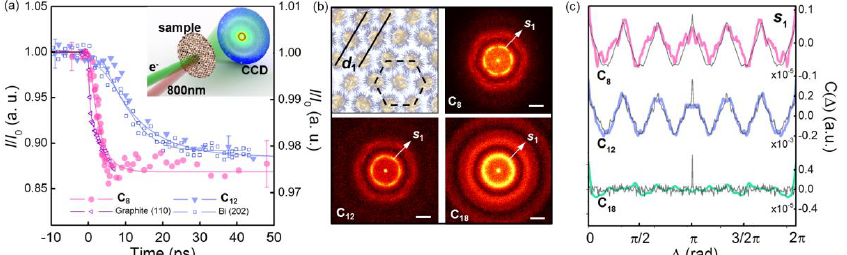
Fig. 1. (a) Ligand length-dependent dynamic response of C8 and C12 supracrystals upon photoexcitation, compared to the time-response of graphite and Bismuth [9] in UED transmission experiments. Inset: Ultrafast small-angle electron scattering experimental layout. (b) Schematic illustration of a two-dimensional monolayer of alkanethiol- functionalized NPs with NPs arranged in a hexagonal lattice with crystallographic planes distance d 1 , and FT simulation from the TEM images of each sample. (c) The CCF for each sample (C8 pink, C12 blue, C18 green) at s 1 =2π/d 1 , from small-angle UED experiments, is compared to the ones obtained at s 1 from the corresponding FT simulation (grey